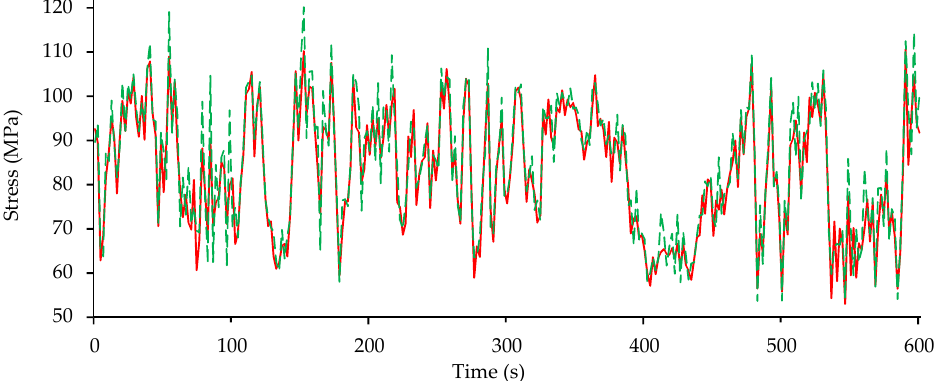
Figure 12. Stress series of models Fix 0 (full line) and Pt 0 (dashed line) for the maximum registered von Mises stress.